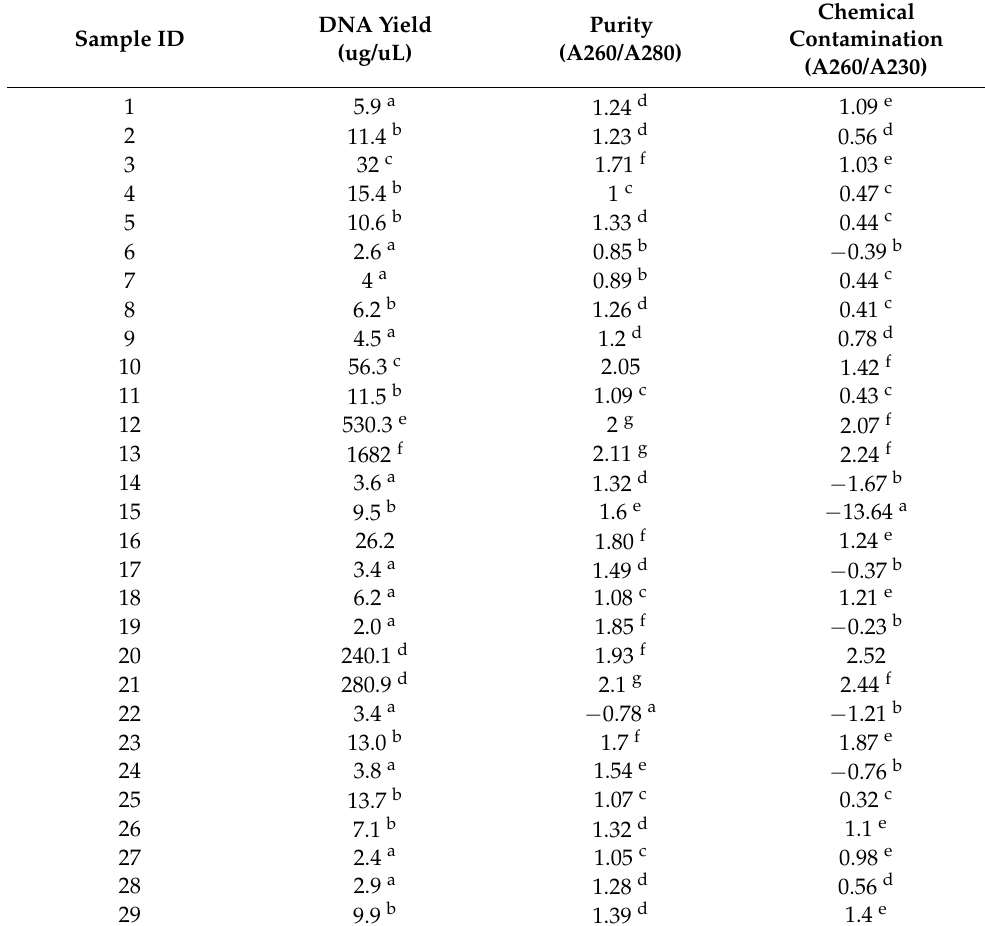
Table 4. Quality differences among the tuna groups. DNA Sample ID